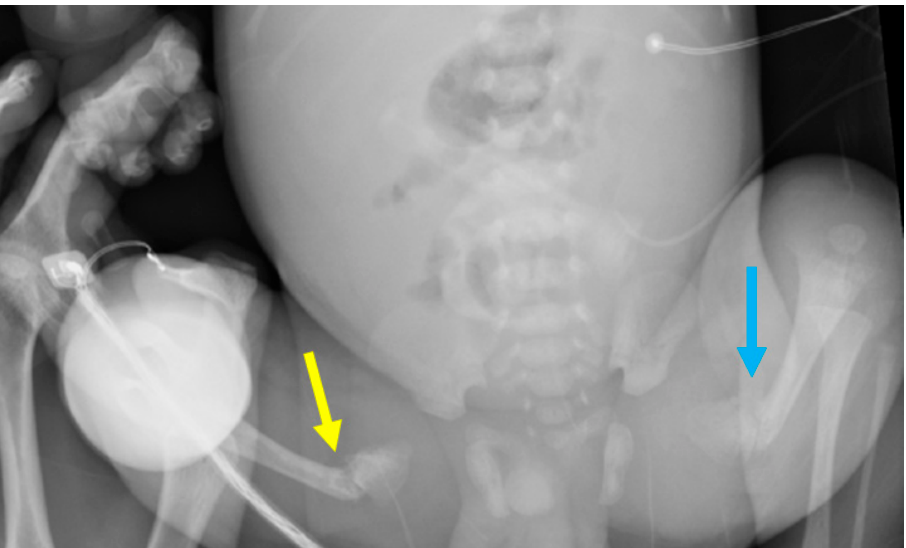
Figure 5. The pediatric long-bone survey taken on the day of birth indicated a displaced, healing fracture of the left proximal femoral diaphysis, with a 7 mm posterior displacement of the distal fragment (blue arrow). There was a partially imaged healing fracture of the right proximal femur (yellow arrow). Holick MF, copyright 2021.